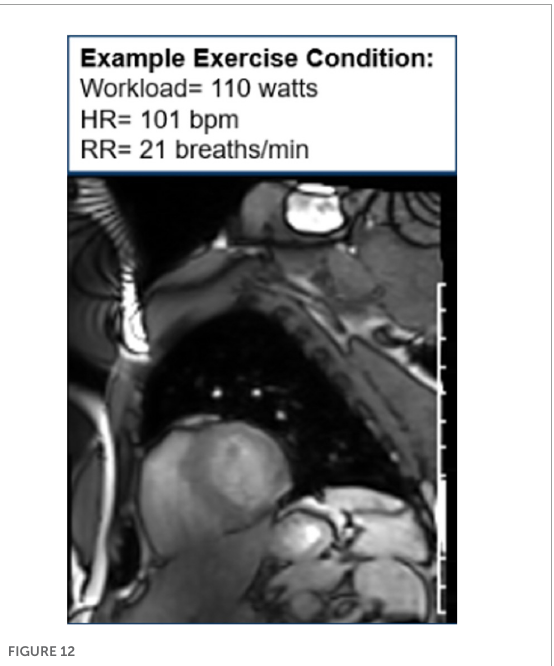
FIGURE11 Cine image at rest. One image of a cine loop at the end short-axis view of the myocardium. The left ventricle is gray, while the blood pool is white. At rest, the workload is 0 w, and the patient’s heart rate is 50 bpm and respiratory rate is 11 breaths/min.